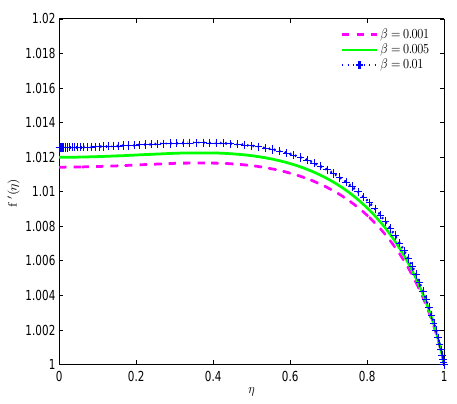
Fig. 3: Variation of f (cid:48) with β at α = 0.01 , γ = 0.01 , Re = 10.0 , K = 10.0 and Λ = 0.001 .